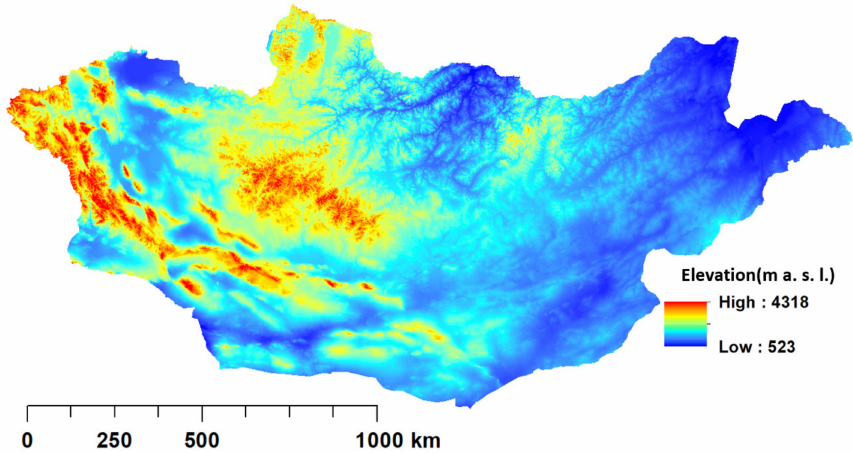
Figure 5. Elevation of Mongolia developed using a digital elevation